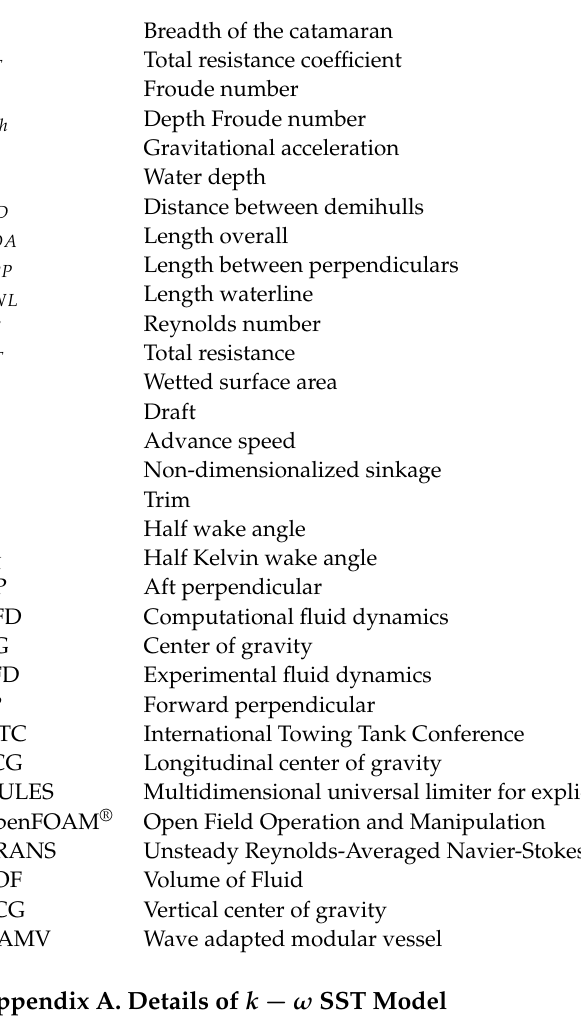
Table A1. The constants of SST k